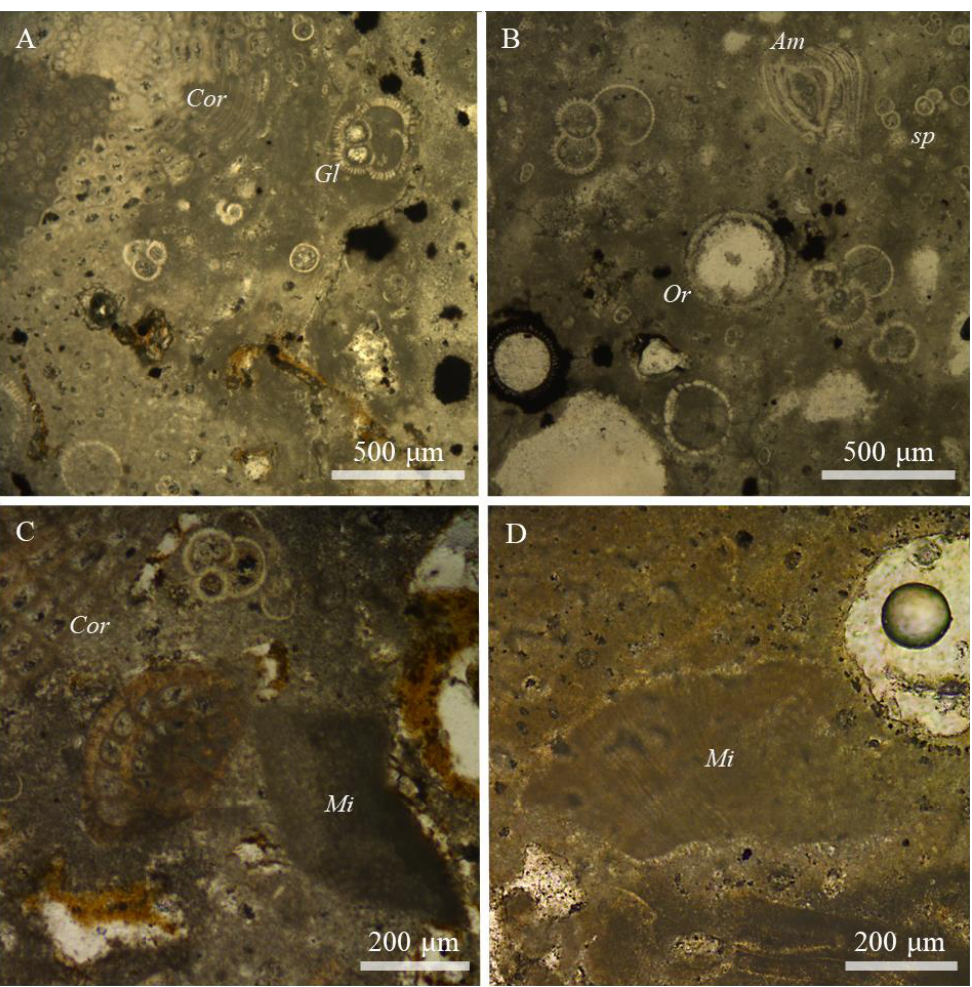
Figure 2. Thin polished section photomicrographs of carbonate rocks from Zhaoshu plateau. ( A )